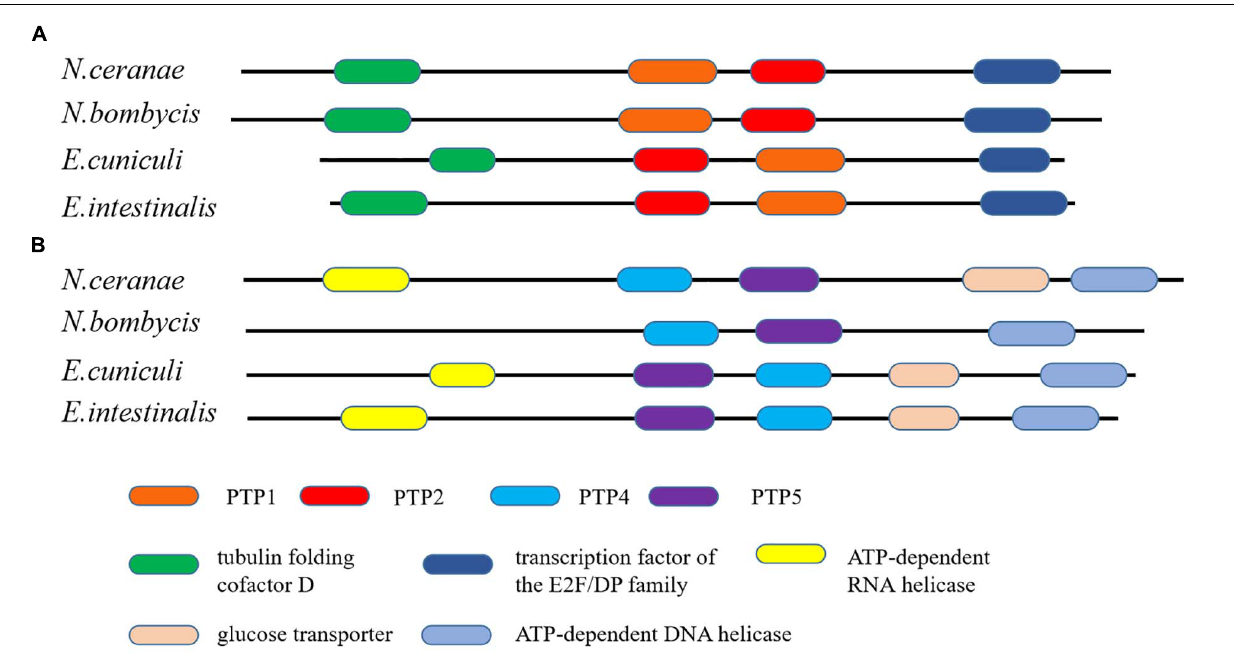
FIGURE 10 | The conservation of gene order among N. ceranae and three other related microsporidian species. (A) The distribution of PTP1 and PTP2 genes in the synteny block. (B) The distribution of PTP4 and PTP5 genes in the synteny block. The colored oblong represents genes with functional annotations.